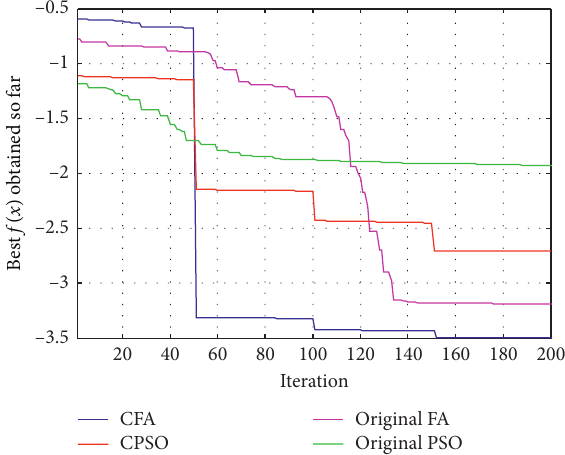
Figure 4: The convergence curve of the best f ( x ) obtained so far by original PSO, original FA, CPSO, and CFA for problem